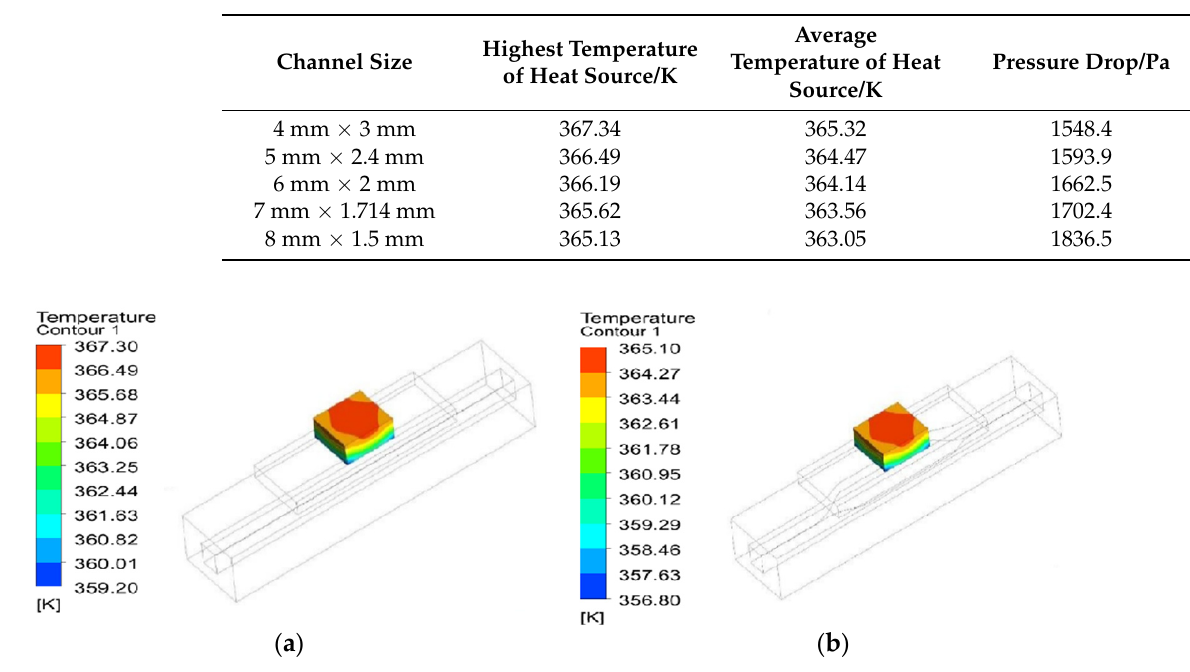
Table 3. Simulation results of different channel size.